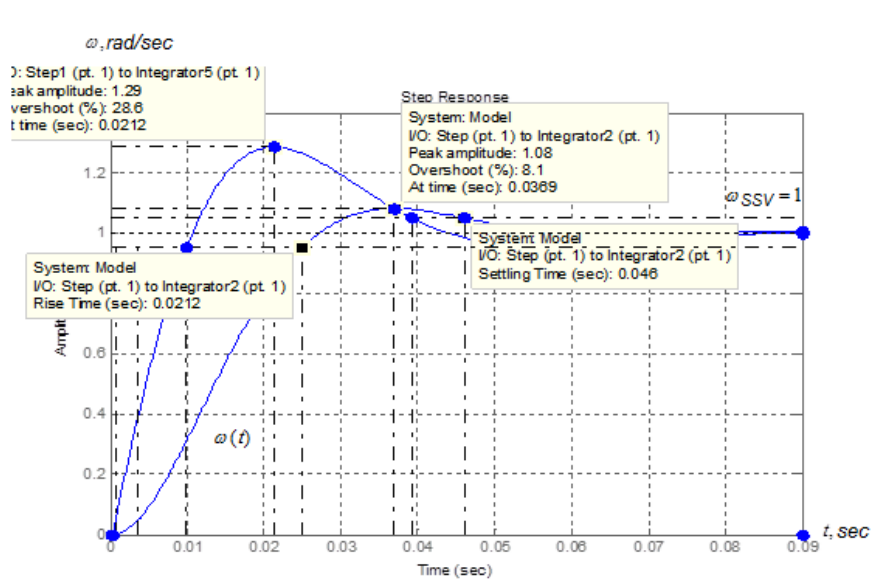
Figure 10. Transient characteristics of speed loop that is tuned on symmetrical